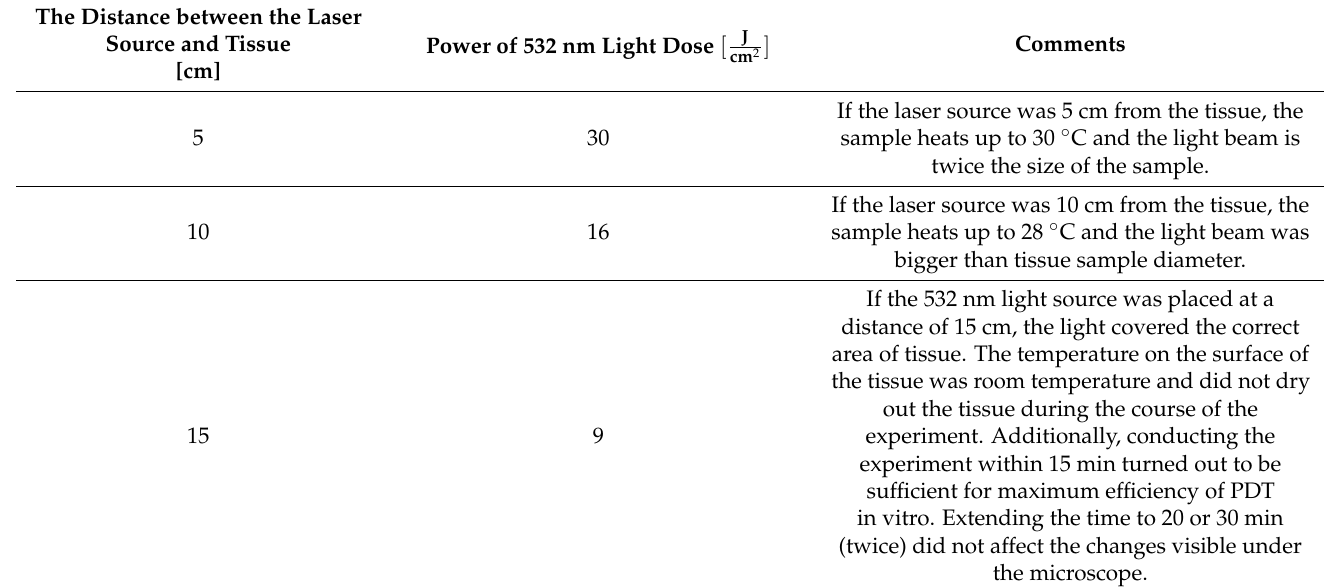
Table 2. Results of optimization of the distance between the laser light source and the sample.